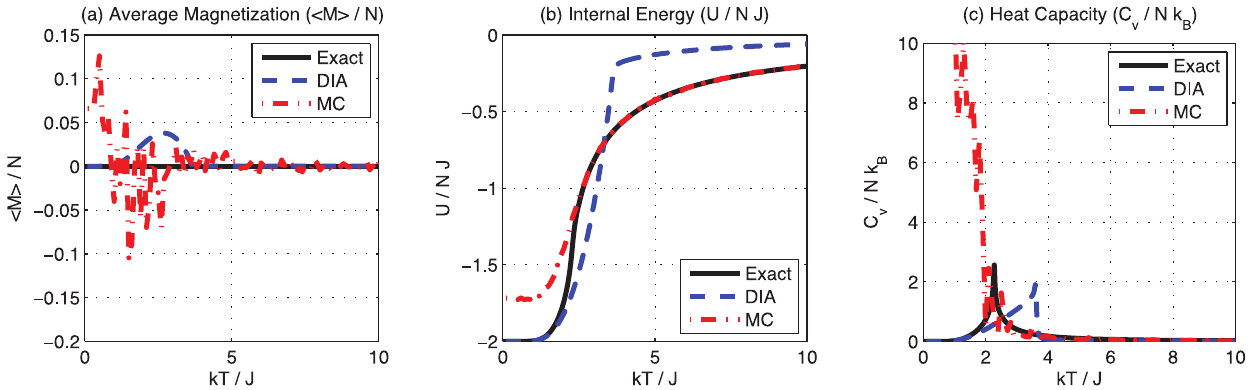
Figure 5. Calculated values for the 128 6 128 2D Ising system. (a) Thermal average magnetization v M w , (b) internal energy U and (c) heat capacity C v , as a function of dimensionless temperature k B T = J for the 128 6 128 2D Ising system, as calculated by the direct interaction algorithm (DIA), the Metropolis Monte Carlo (MC) method, and the exact solution. The number of steps for the MC method was chosen such that the MC computation time is at least 10 times the computation time for the DIA. Connecting lines are shown to guide the eye.